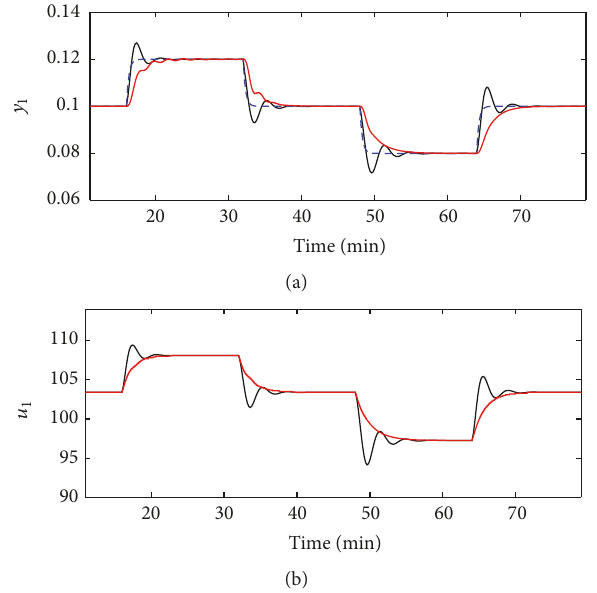
Figure 4: Performance of the gain-scheduling PI in Case 1 and a conventional PI with 𝐾 𝑐 = 44.0 and 𝜏 𝐼 = 0.25 . (a) Set-point (dashed blue line), gain-scheduling controller (black line), and conventional PI(redline).(b)Manipulatedvariableforgain-schedulingcontroller (black line) and conventional PI (red